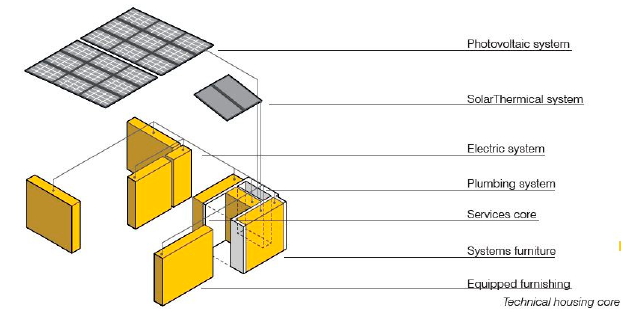
Figure 14. Scheme about generation and energy consumption.